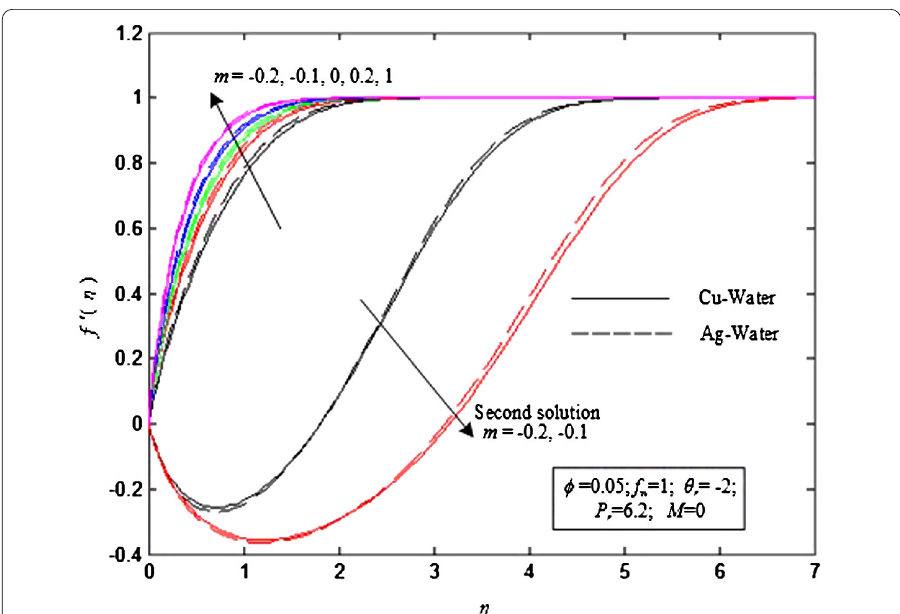
Figure 4 Velocity profile of Cu/Ag-Water nanofluids for representative values of m .